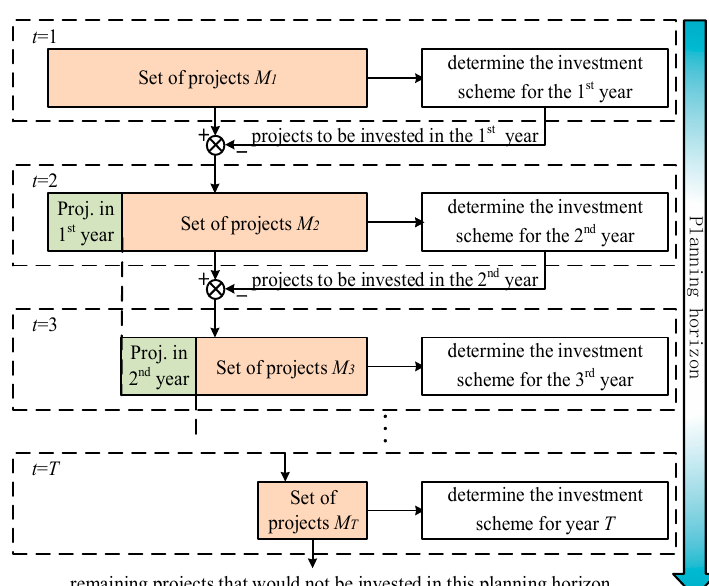
Figure 6. Evolution of Mt during the planning horizon.